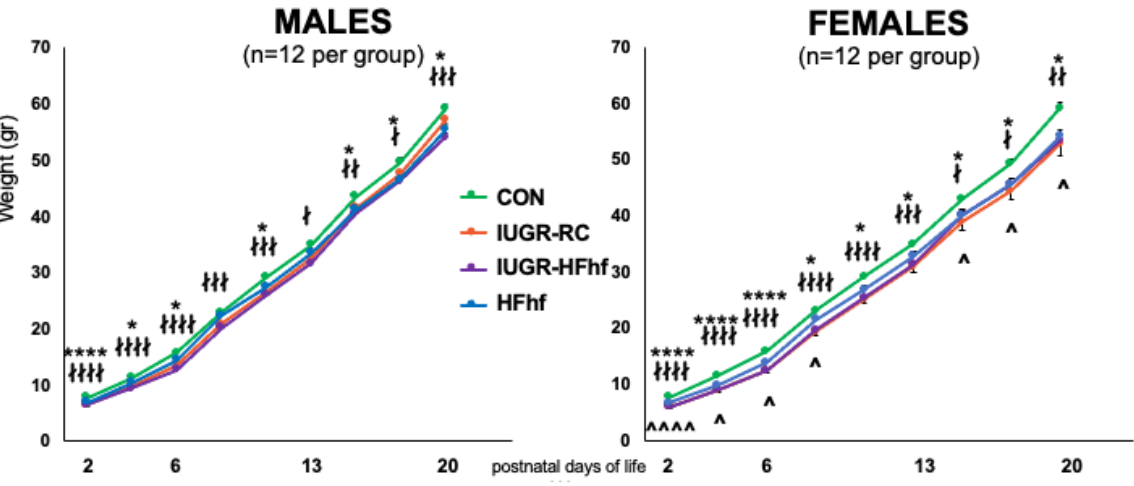
Figure 2. Postnatal Body weights in males and females of the four experimental groups. CON = control, IUGR-RC = Intra-uterine growth restriction on a regular chow diet, HFhf = high fat and high fructose diet, IUGR-HFhf = Intra-uterine growth restriction on a high fat high fructose diet. n = 12 litters per experimental group were examined. *compares HFhf versus CON, ∤ IUGR-RC versus CON, compares males versus females, * or ∤ p < 0.05, ∤∤ p < 0.01, ∤∤∤ p < 0.005, ****or ∤∤∤∤ p < 0.0001. ^ p<0.05, ^^^^ p<0.001.